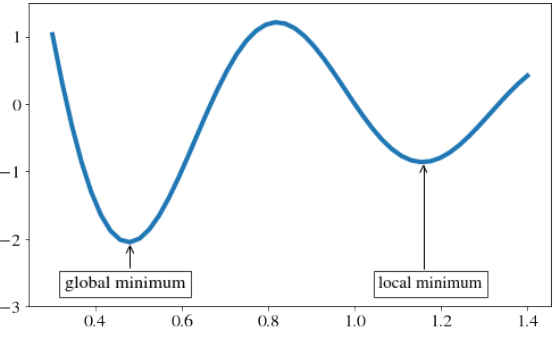
Figure 4. Illustration of local minimum and global minimum.